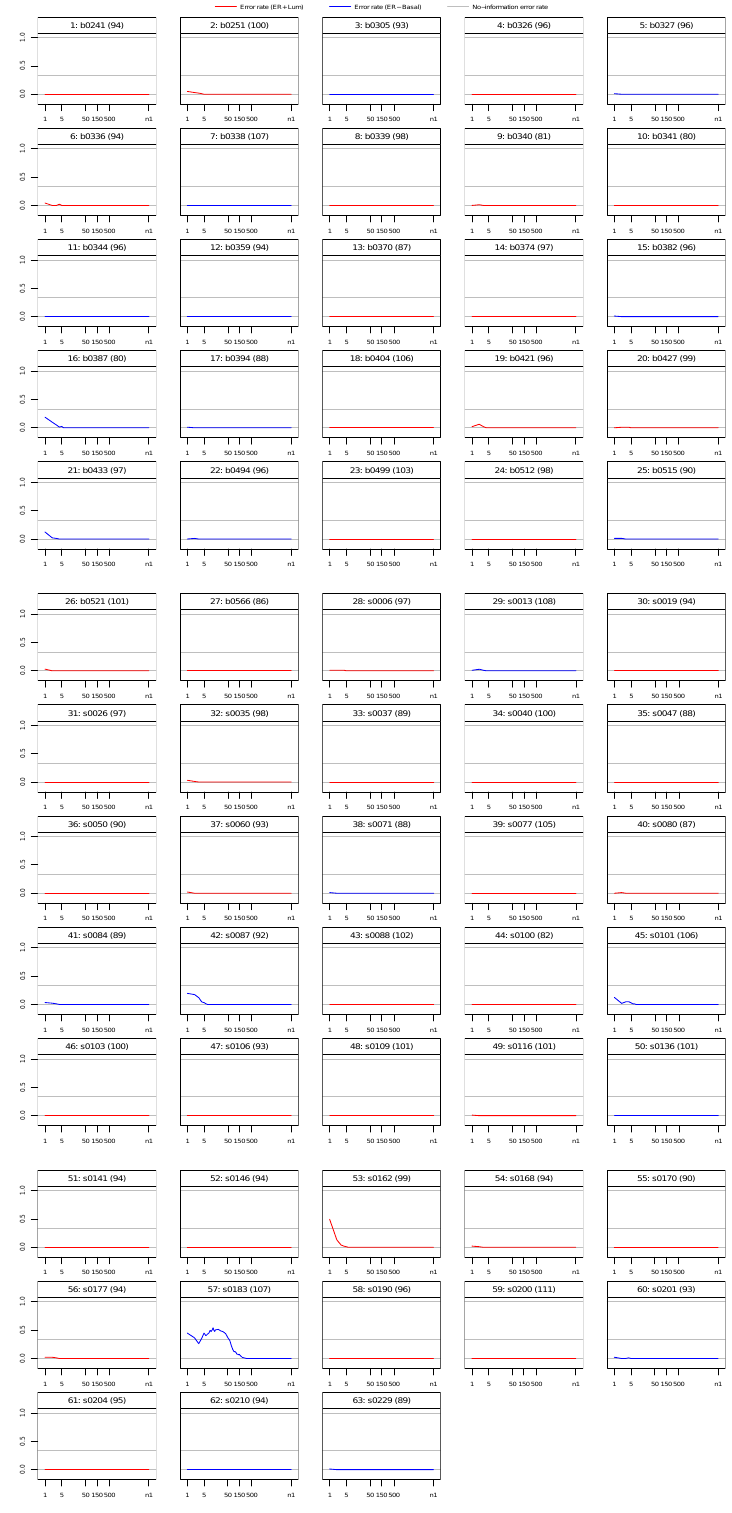
Sample-tracking analysis of the Lum/ER+ vs. Basal/ER- task on the expression data. For each sample, the plot indicates percent error for BioDCV runs (indicated in parenthes) in which the sample is in test, averaged on models of the same feature set size. The horizontal grey line indicates the no-information error rate for baseline comparison. Error rate (ER−